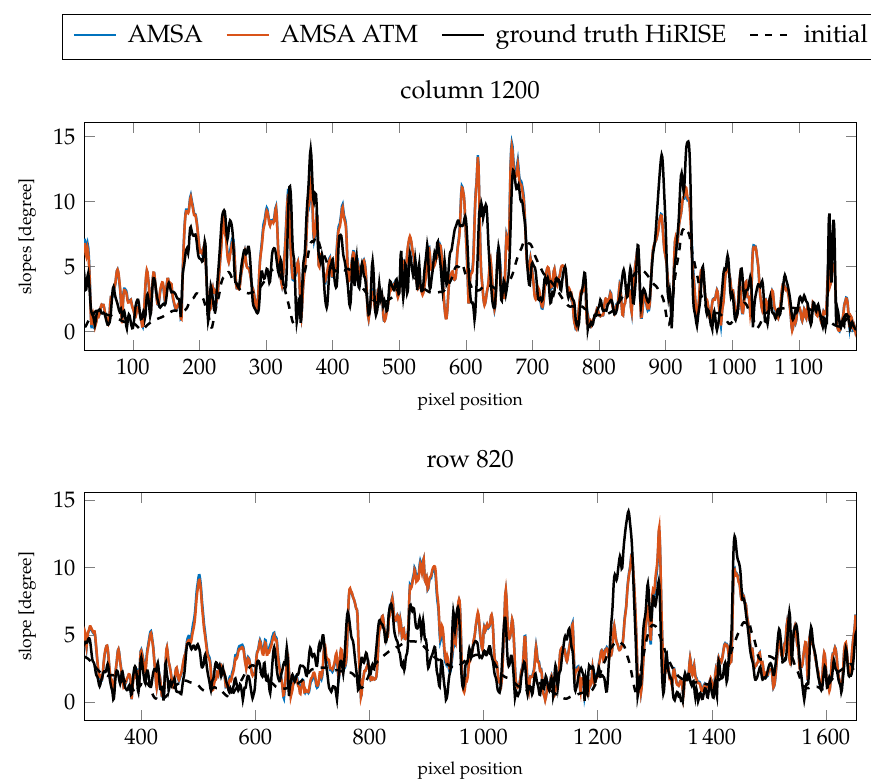
Figure 10. Resulting slopes compared for the two profiles investigated for image G20_025970_2217_XN_41N102W. The resulting color-coded DEMs for γ = 3